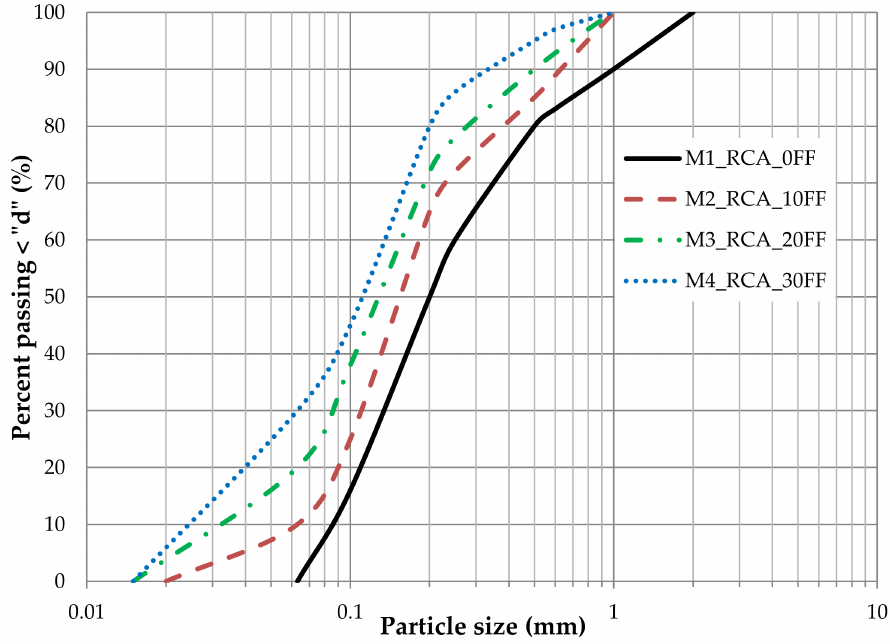
Figure 2. The particle size distribution curves of M1, M2, M3, and M4 used for this study. The soil was classified as sand (Sa) for mixtures M1_RCA_0FF and M2_RCA_10FF and sand with silt (siSa) for mixtures M3_RCA_20FF and M4_RCA_30FF, following PN-EN ISO 14688-2:2006 [21]. The main properties of these mixtures of RCA are given in Table 3. The specific gravity for all used materials was found to be